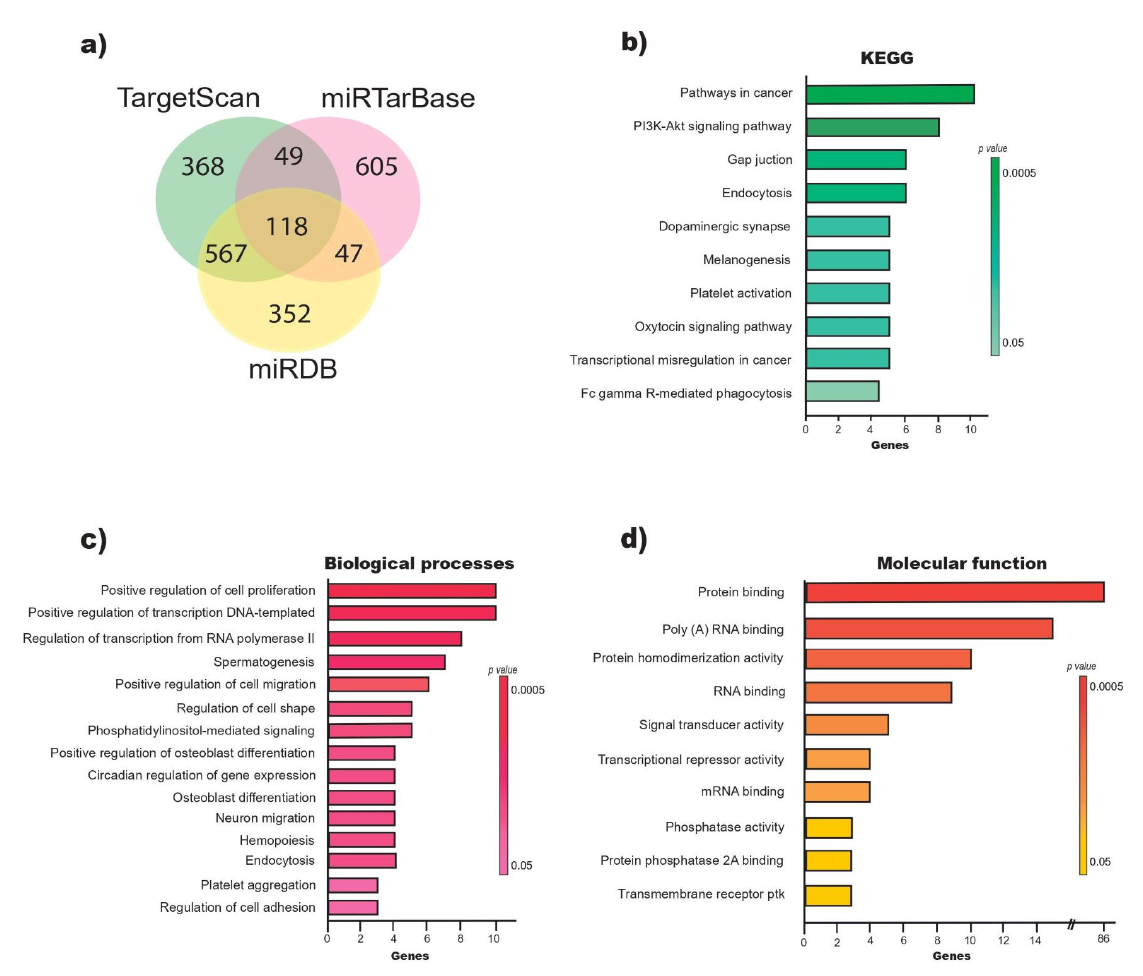
Figure 2. Prediction of miR-218-5p target genes and functional analysis (Top of pathways). ( a ) Number of miR-218-5p target genes predicted in TargetScan, miRTarBase and miRDB. ( b ) KEGG analysis of 118 miR-218-5p target genes overlap in the three databases. ( c ) Biological processes in the participate the 118 miR-218-5p target genes and ( d ) molecular function. Table 1. miR-218-5p target genes in overlap in TargetScan, miRTarbase and miRDB databases. 118 Genes Predicted to Be Targeted by